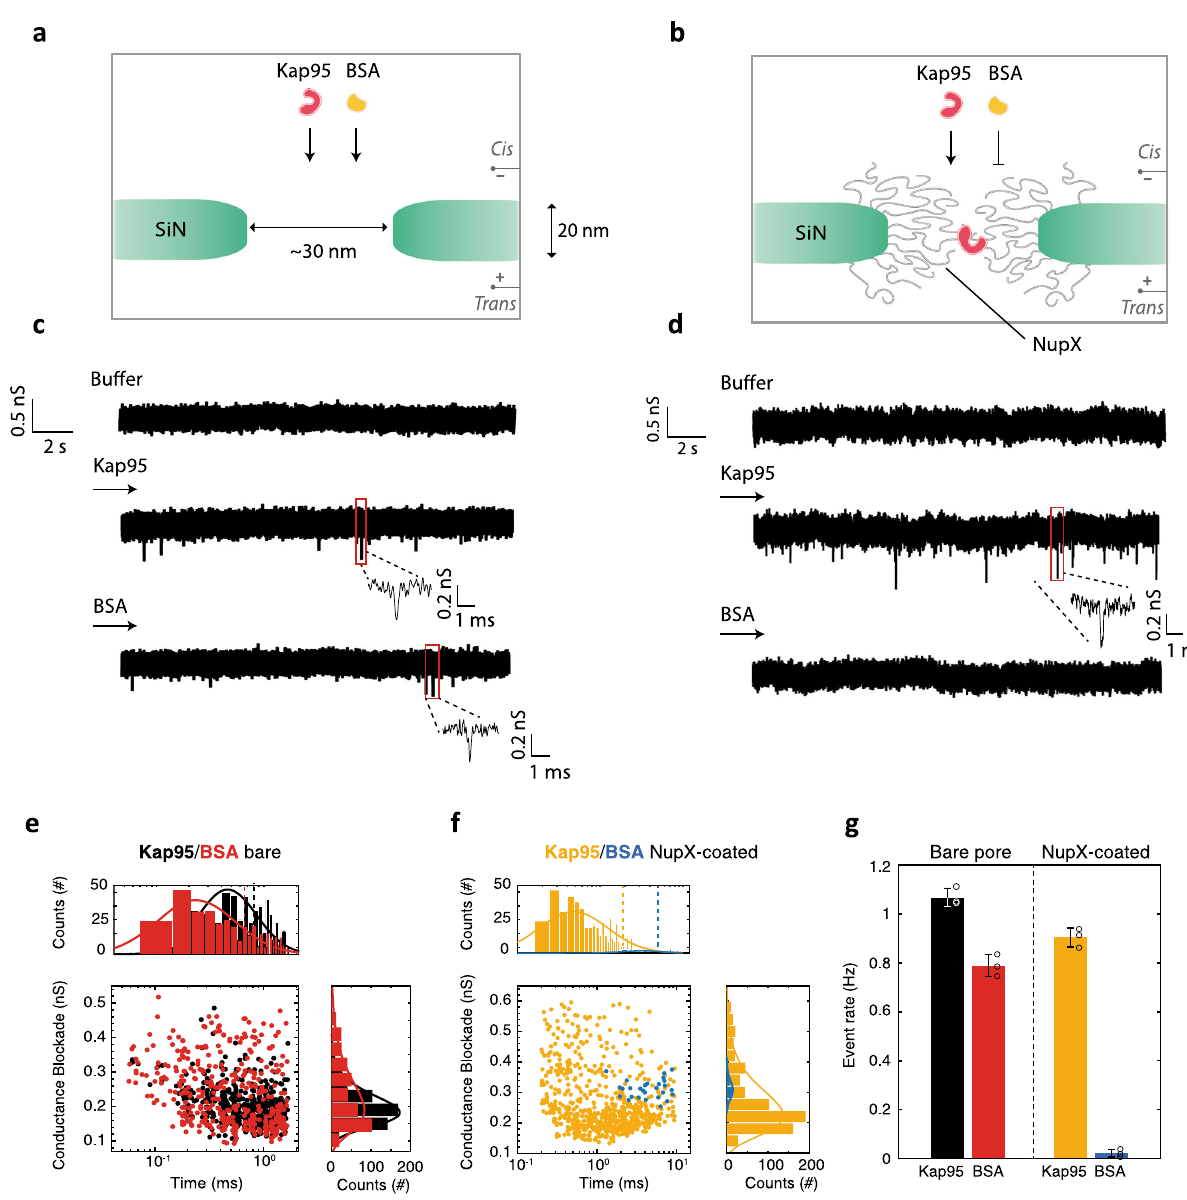
Fig. 3 Electrical measurements on NupX-coated solid-state nanopores. a , b Schematic of the nanopore system before ( a ) and after ( b ) NupX functionalization. c, d Examples of raw current traces through bare ( c ) and NupX-coated ( d ) pores, recorded under 100 mV applied bias for different analyte conditions. Current traces are recorded in the presence of buffer only (top), upon addition of 450 nM Kap95 (middle) and 2.8 μ M BSA (bottom). Traces were fi ltered at 5 kHz. e Scatter plot showing conductance blockades and dwell time distributions of translocation events of the analytes Kap95 (black, N = 506) and BSA (red, N = 387) through a bare 30 nm pore, recorded over the same time interval. f Scatter plot showing conductance blockades and dwell time distributions of translocation events of the analytes Kap95 (yellow, N = 686) and BSA (blue, N = 28) through a NupX-coated 30 nm pore, recorded over the same time interval. Top and right panels in e and f show lognormal fi ts to the distribution of dwell times and conductance blockades, respectively. Dashed vertical lines in top panels indicate the mean values for the dwell time distributions. g Average event rate of translocations for Kap95 through a bare pore (black), BSA through a bare pore (red), Kap95 through a NupX-coated pore (yellow) and BSA through a NupX-coated pore (blue). Error bars indicate standard deviations from independent measurements (circles) on three different pores, N = molecules in the pore signi fi cantly slows down the translocation 60 nm NupX-coated pore (Supplementary Fig. 15) yielded process of the passing molecules. Notably, BSA molecules were slower in translocating through the coated pore as compared to Kap95, which we attribute to the lower af fi nity between BSA and the NupX mesh as compared to Kap95. The transient and multivalent interactions between Kap95 and the FG repeats in the NupX meshwork lead to a reduced energy barrier as compared to BSA permeation, which may explain the observed differences in dwelling times 10 . Repeating the same experiment on a larger